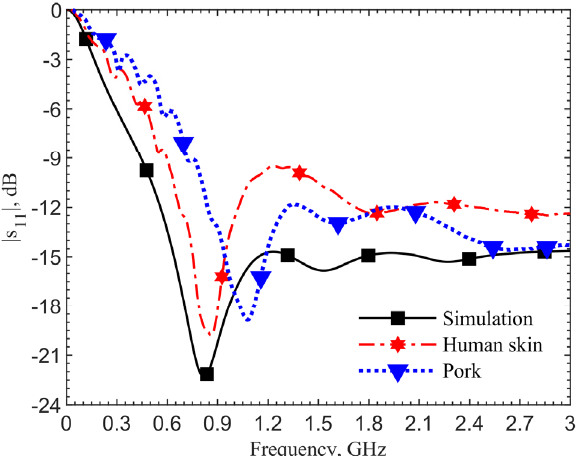
Figure 11. Comparison of results by the simulation utilizing the documented frequency-dependent human skin electrical properties, by the measurement on top of a person’s forearm skin, and by the measurement on the top surface of the ground pork